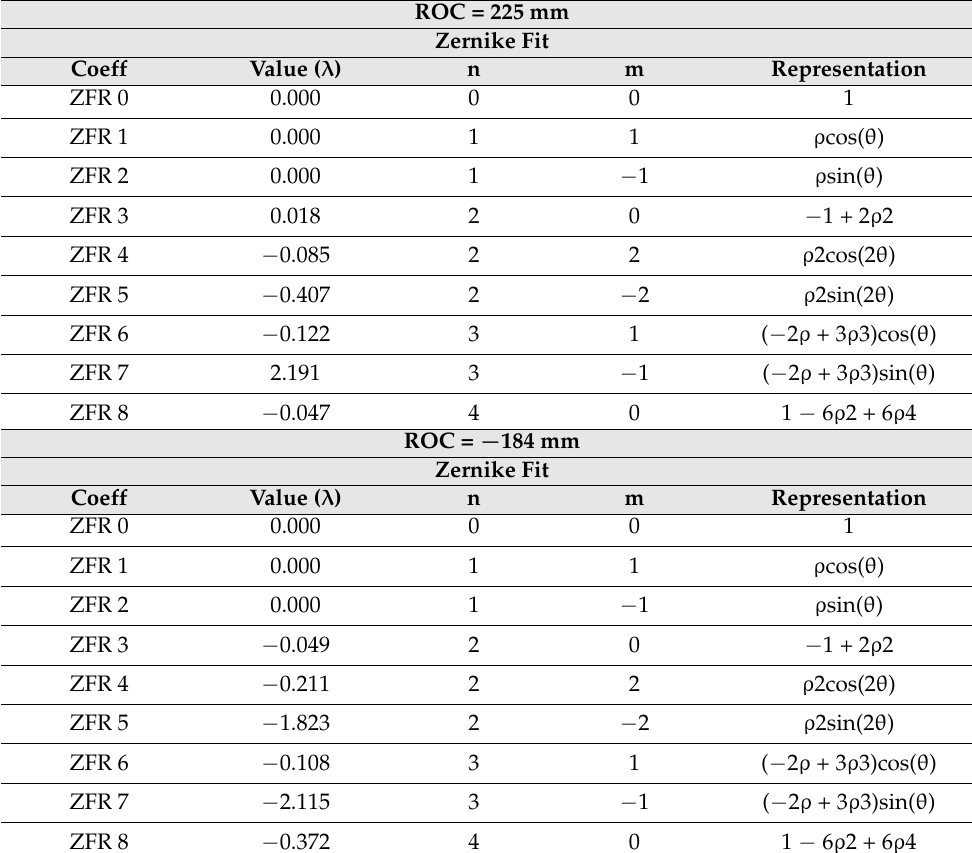
Table 1. Results from the Zernike fit coefficients obtained from the data in Figure 6, for positive ROC (top) and negative ROC (bottom).